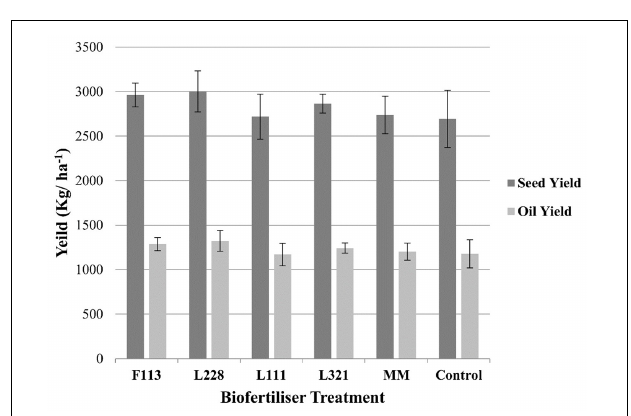
FIGURE 4 | Seed and oil yield output from B. napus in a field experiment following inoculation by PGP Pseudomonas and a bacterial consortium at harvest. Error bars represent the standard error of the mean ( ± SE). There were no significant differences found in seed or oil